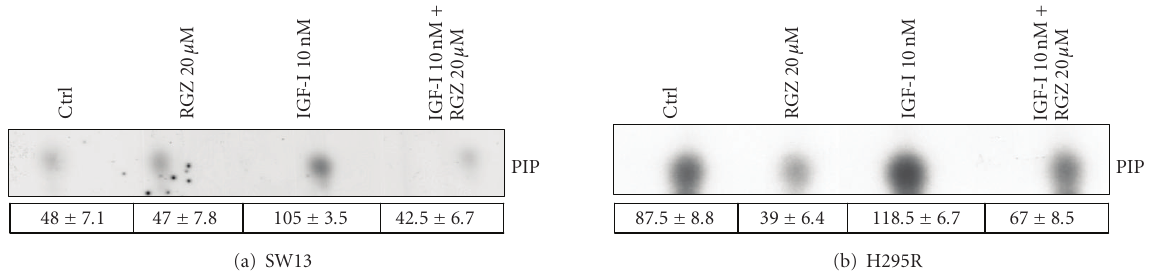
Figure 5: RGZ inhibits IGF-I stimulated PI3K . PI3K activity in SW13 (a) and H295R (b) treated or not for 15 minutes with 10 nM IGF-I and 20 μ M RGZ was evaluated by an in vitro assay after immunoprecipitation with an antibody against the PI3K regulatory subunit p85. The spots correspond to PI3K catalytic product [ 32 P]phosphatidyl inositol phosphate (PIP). Representative of two similar experiments. Mean ± SE ( n = 2) of phospho-Akt band intensity (arbitrary units) is shown in the table under each blot.